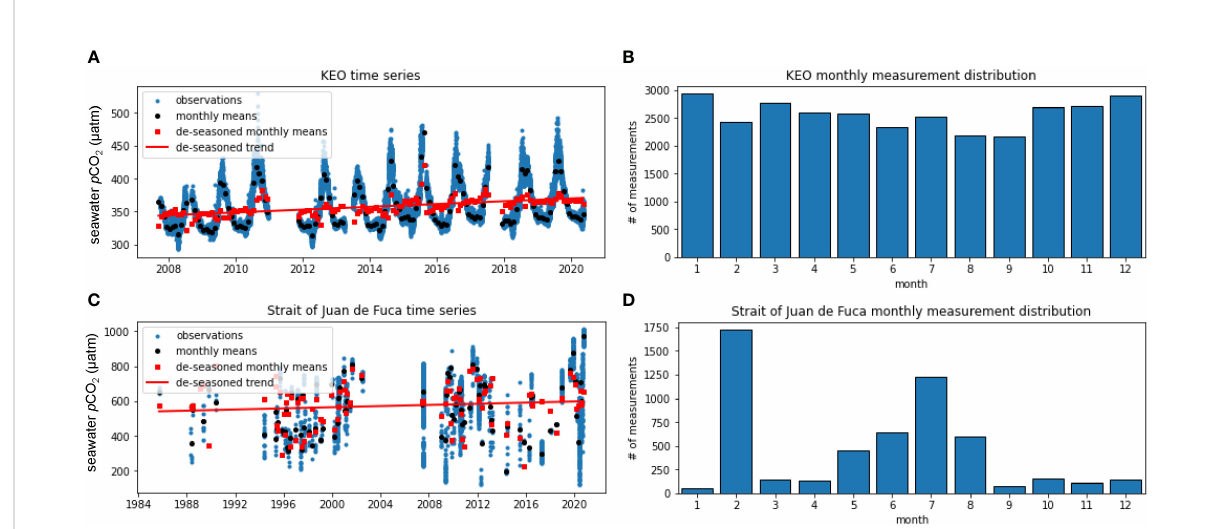
FIGURE 5 Surface seawater p CO 2 (µatm) from the KEO mooring (A) and ship-based underway measurements in the Strait of Juan de Fuca (C) including the original time-series observations (blue circles), the time series of monthly means (black circles), the de-seasoned monthly means (red squares), and the trend of the de-seasoned monthly means (red line). Monthly measurement distribution of the KEO (B) and Strait of Juan de Fuca (D) time series are also